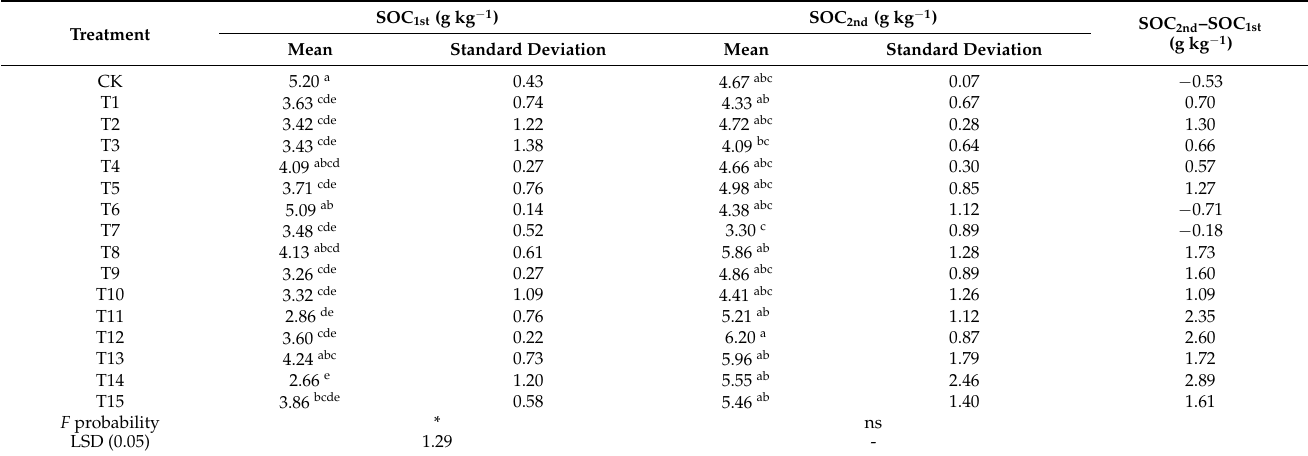
Table 3. Soil organic carbon (SOC) measured in the no-seedling period (SOC 1st ) and the ripping period (SOC 2nd ). Different letters in the same column indicate significant difference at p ≤ 5%.